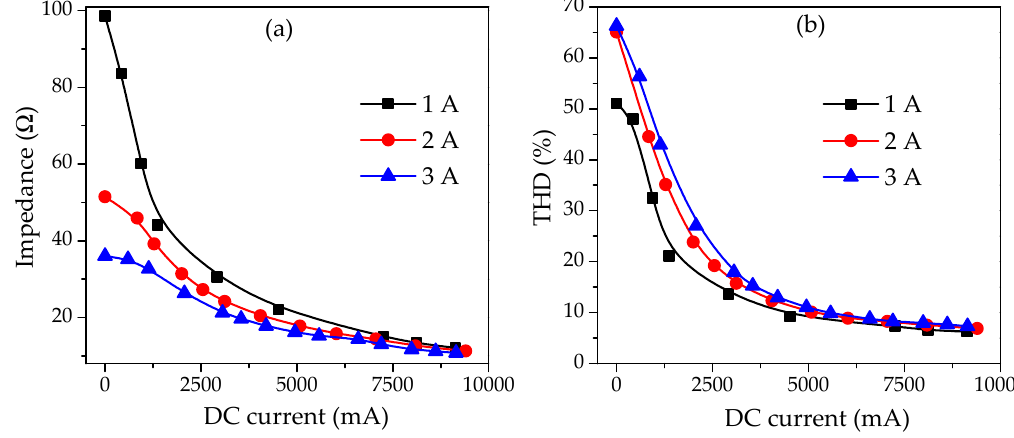
Figure 9. ( a ) Working coil impedance versus DC control current. ( b ) total harmonic distortion (THD) of a working current depending on DC control current.